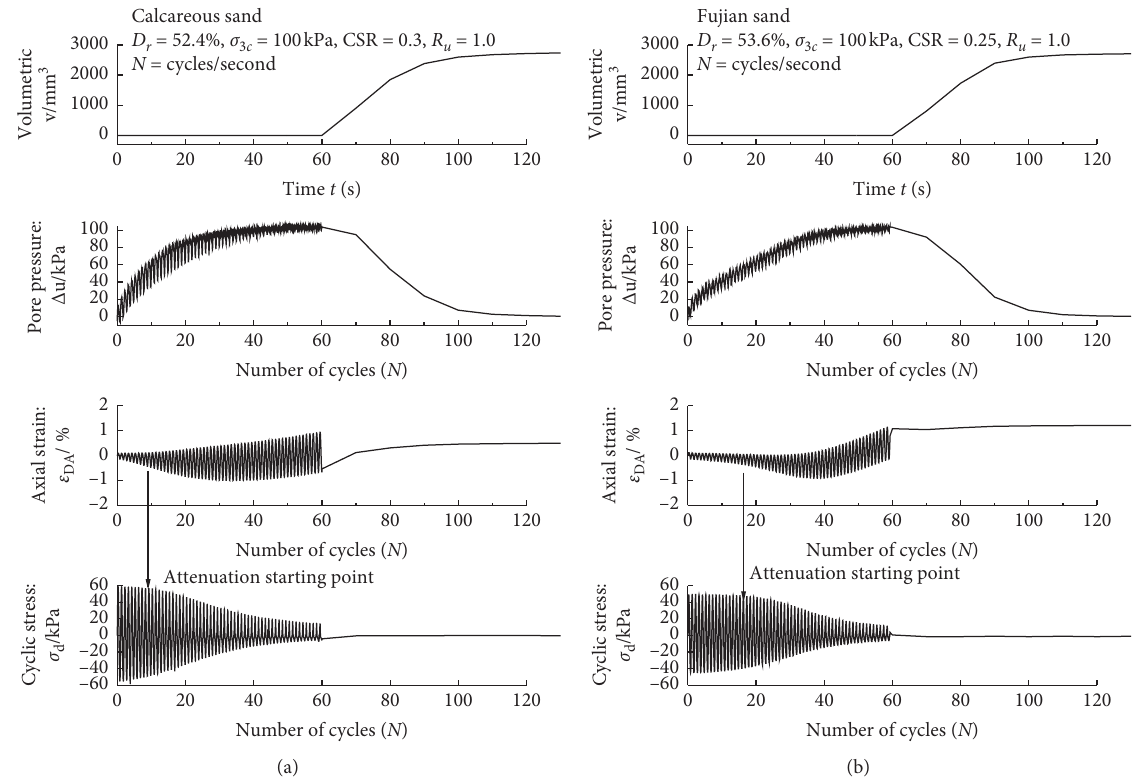
Figure 5: Cyclic triaxial test results of two types of samples: (a) calcareous sand; (b) Fujian sand.